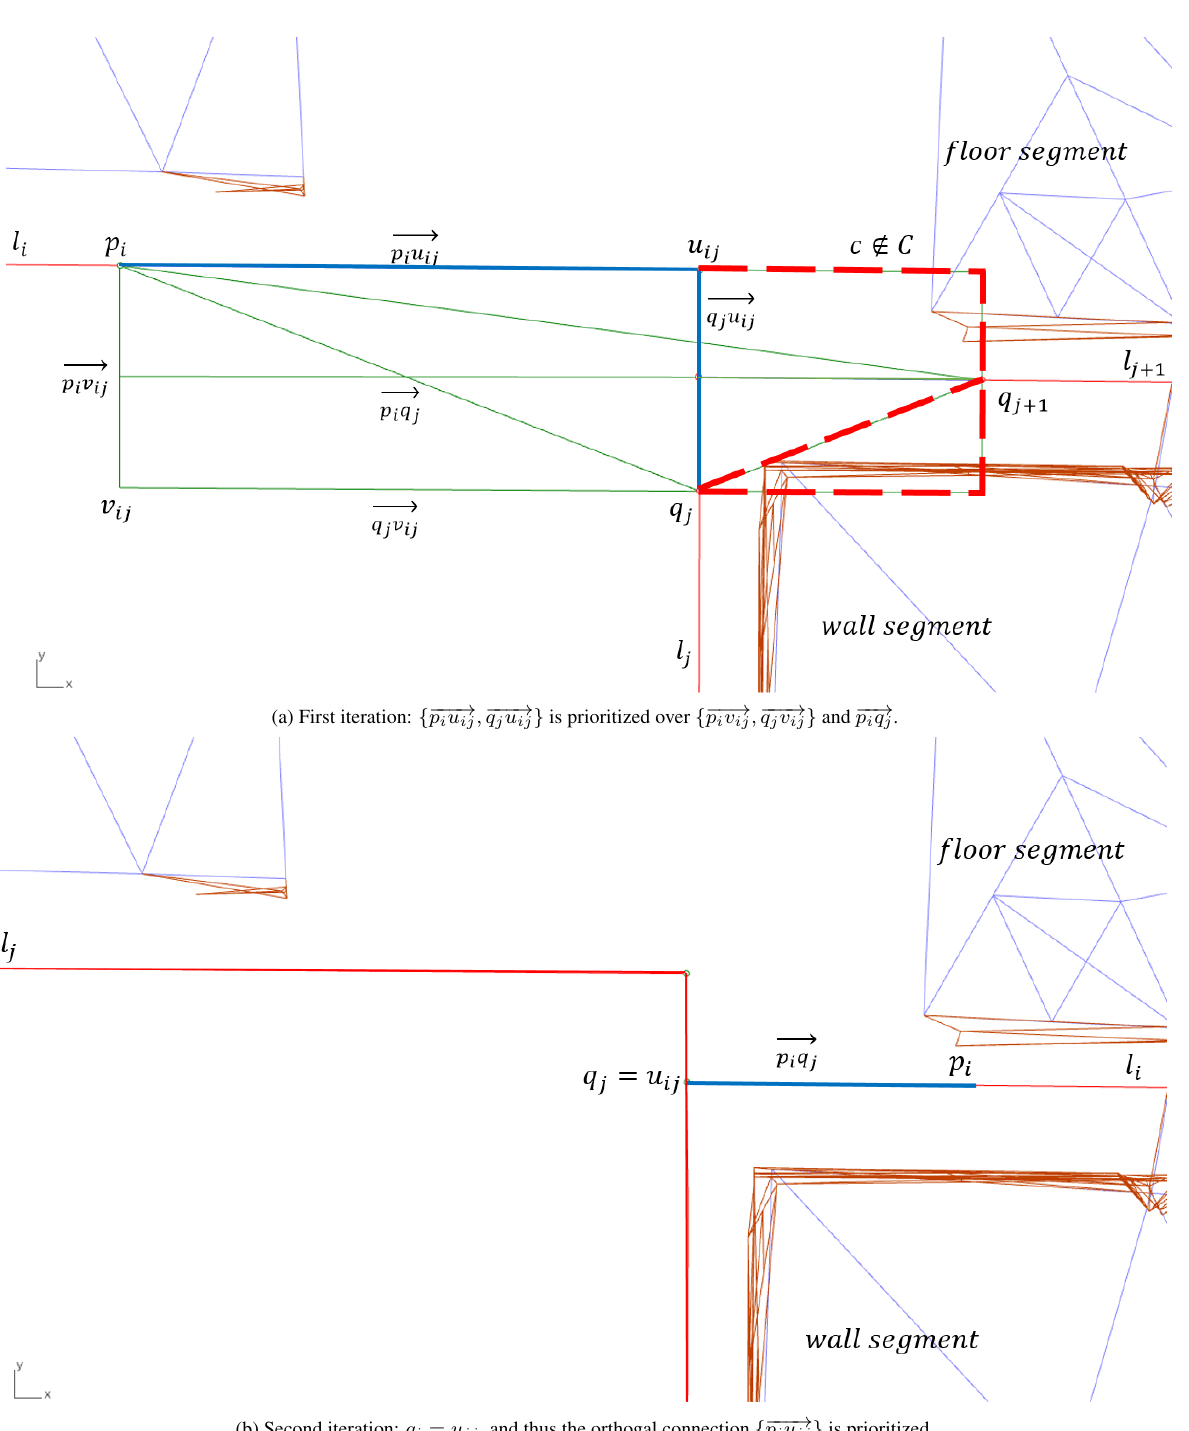
Figure 2. Example wall topology reconstruction of a 3 wall configuration depicting the nearby wall (brown) and floor (purple) segments, the centrelines (red), the potential connections C (green lines), the rejected connections (red dotted lines). The blue lines are the reconstructed centrelines in subsequent iterations to complete the wall